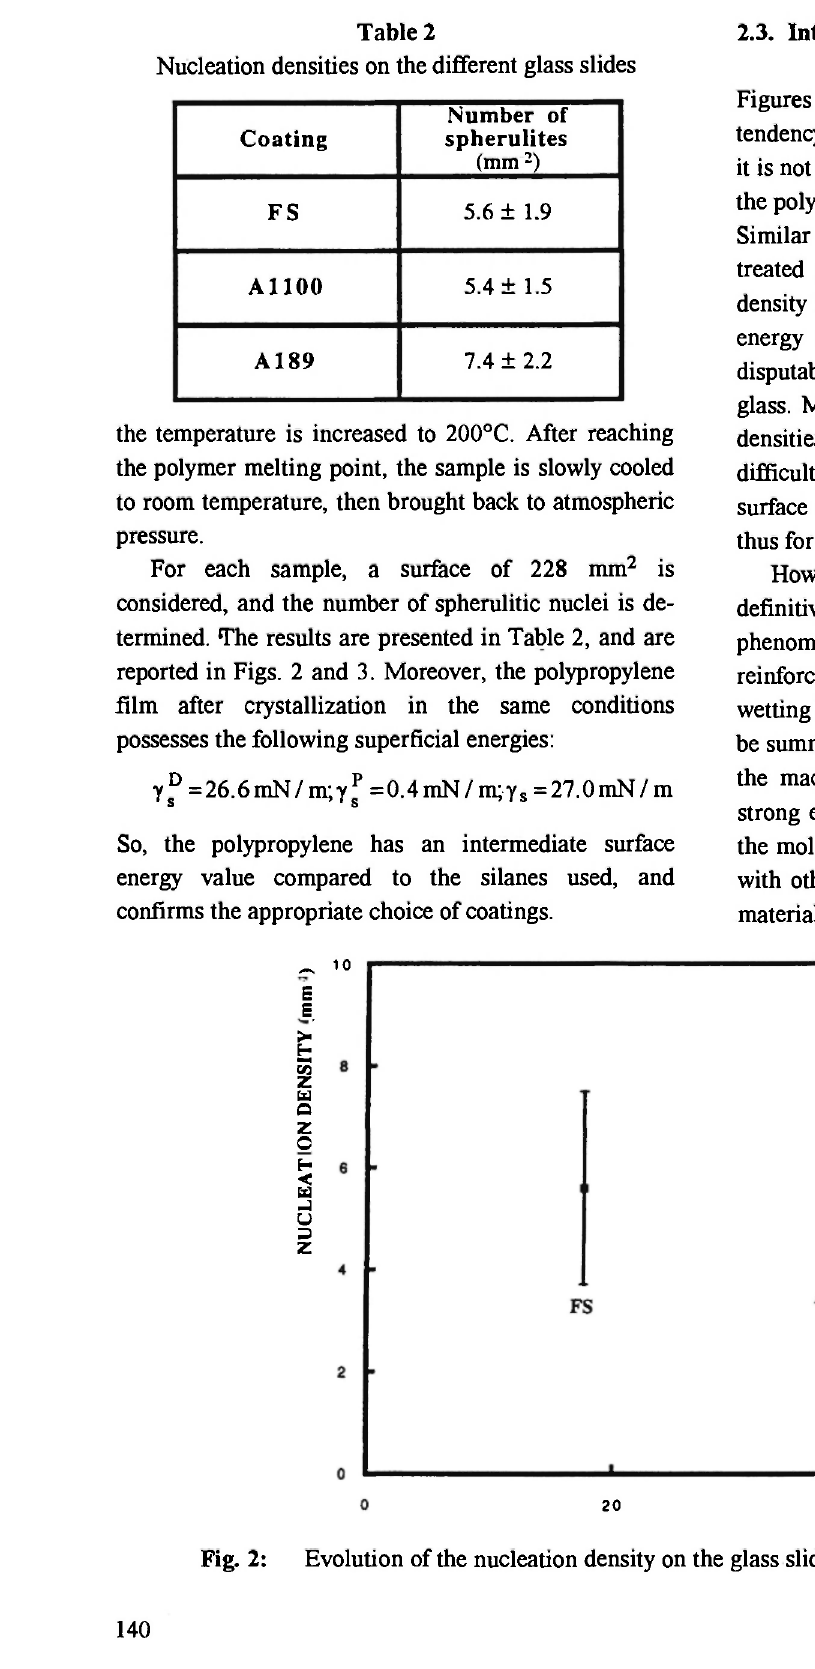
Fig. 2: Evolution of the nucleation density on the glass slides as a function of the surface energy y s